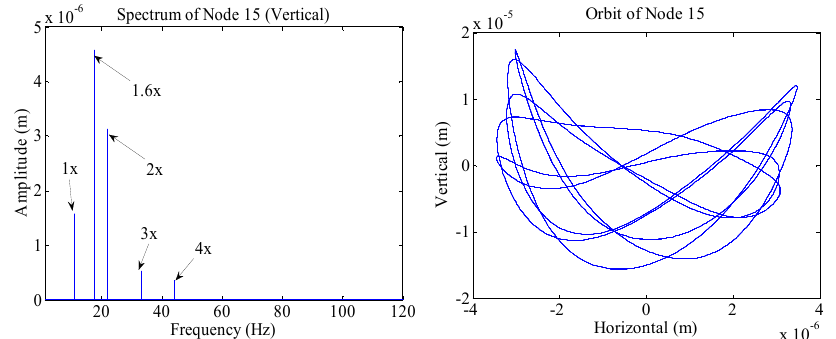
Figure 11. The spectrum and the orbit of Bearing 3 (misalignment at Bearing 3).